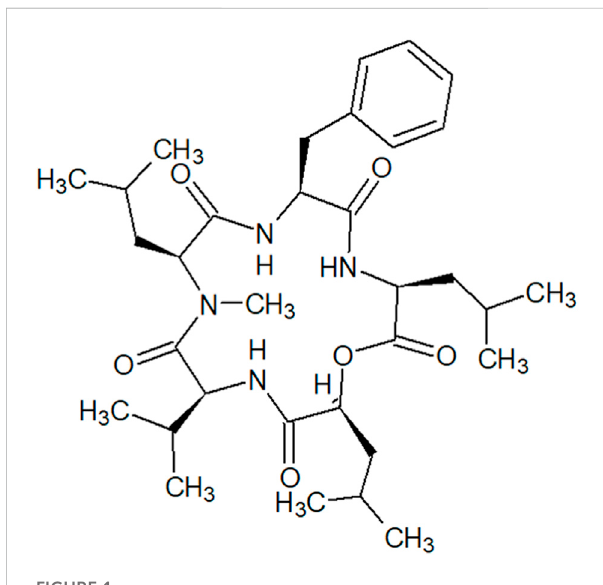
FIGURE 1 Structure of N